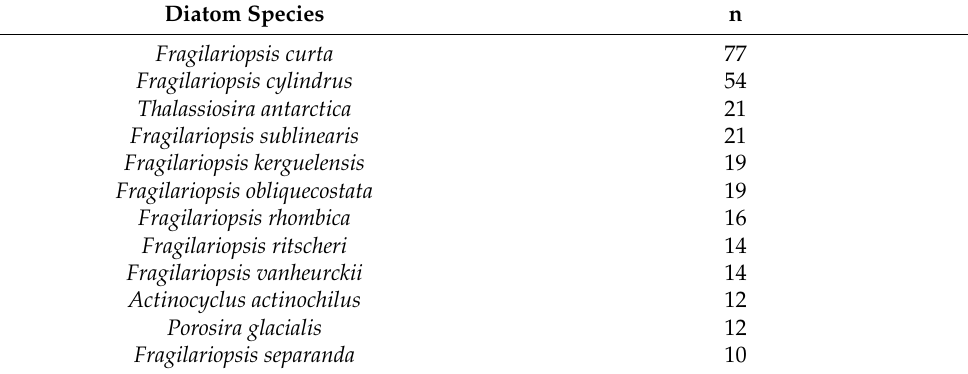
Table 2. The most common diatom taxa in Antarctic sea ice proxies of the past 2 ka.